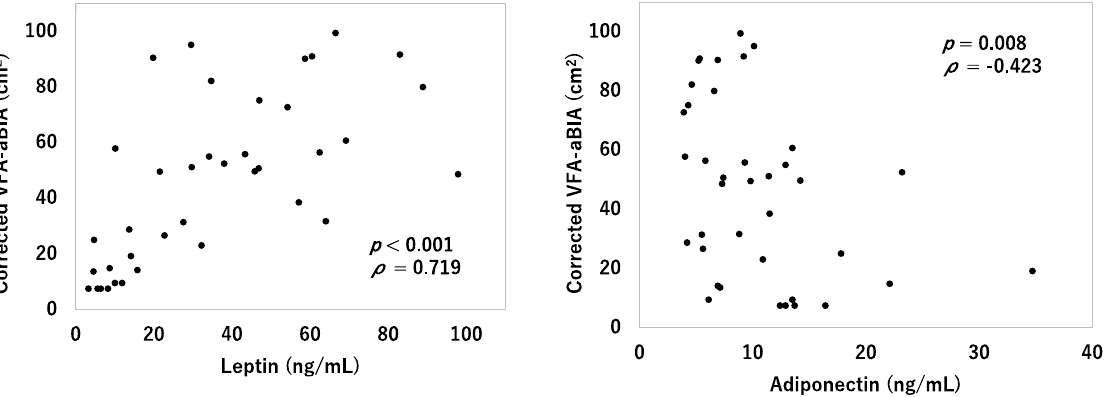
Figure 7. Relationship between corrected VFA-aBIA and serum leptin or adiponectin levels. VFA- aBIA—visceral fat area measured by abdominal bioelectrical impedance analysis using EW-FA90 (Panasonic Corporation, Osaka, Japan).